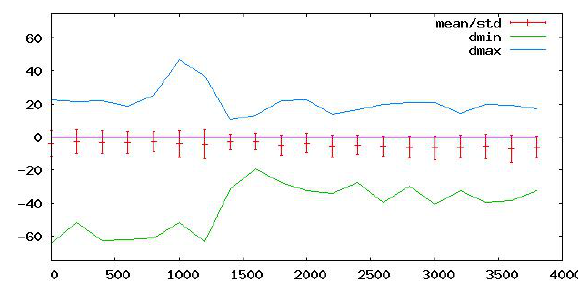
Figure 16: Statistics of whole Terrassa area from north (left) to south (right) for proposed method